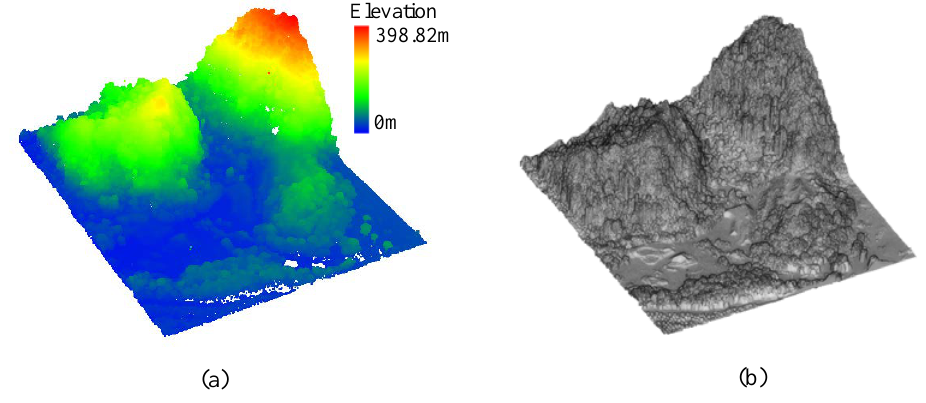
Figure 2. Dense point cloud. ( a ) Original point cloud, ( b ) DSM.